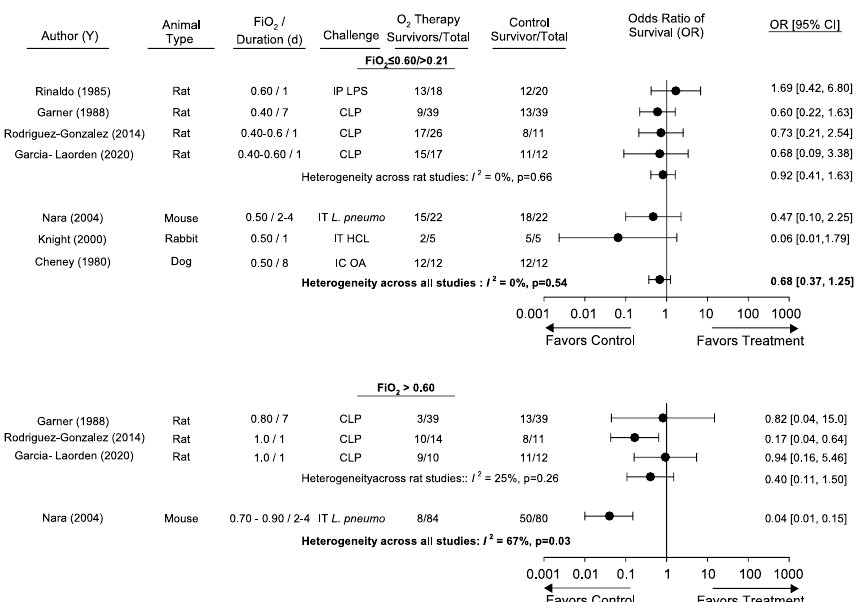
Fig. 1 Effects of either FiO 2 s 0.60 and > O.21 (FiO 2 0.60/ > O.21) (upper panel) or FiO 2 s 0.60 (lower ≤ ≤ ≥ panel) vs. FiO 2 s 0.21 (controls) on the odds ratios of survival (95%CIs) (OR) in studies [author (y)] that also = administered an infectious or noninfectious inflammatory challenge in animals. Animal type, increased FiO 2 level and duration, and inflammatory challenge route and type employed in studies are also shown. Also noted are the numbers of animals surviving and total numbers of animals in oxygen or control groups. Data from individual regimens of oxygen or challenge that were pooled within studies based on nonsignificant heterogeneity ( I 2 level of significance, p 0.10) comparing the regimens are shown in Additional file 1: ≥ Fig. S2. Overall ORs were pooled across animal type and studies if the significance level for heterogeneity was p 0.10. While an overall OR could be calculated for FiO 2 0.60/ > O.21 ( I 2 0%, p 0.54), this was ≥ ≤ = = not possible for FiO HCL hydrochloric acid, OA oleic